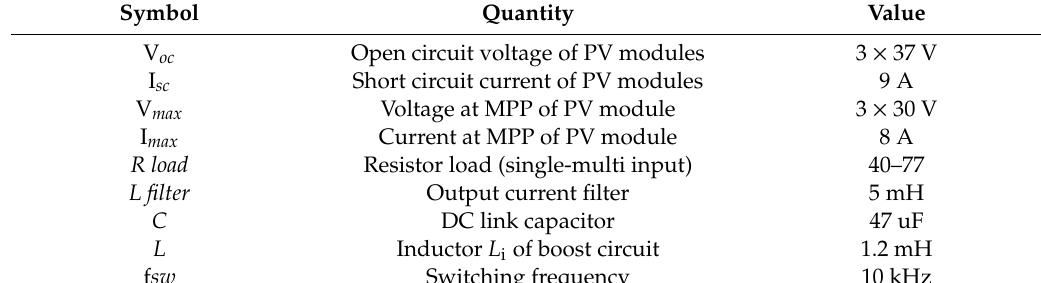
Table 3. Experimental parameters.